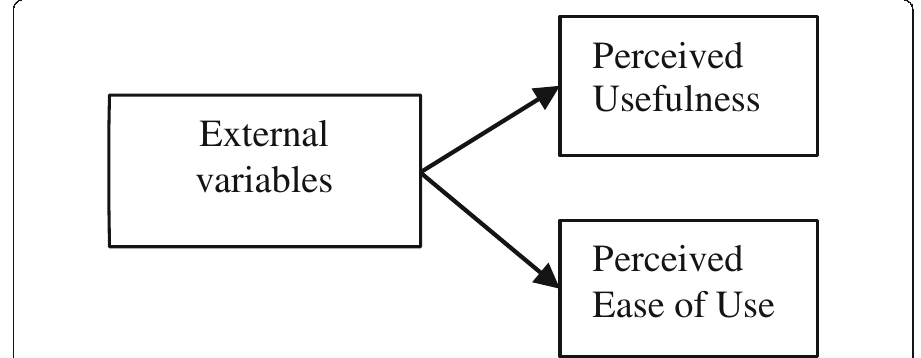
Fig. 2 Effects of external variables on perceived usefulness and perceived ease of